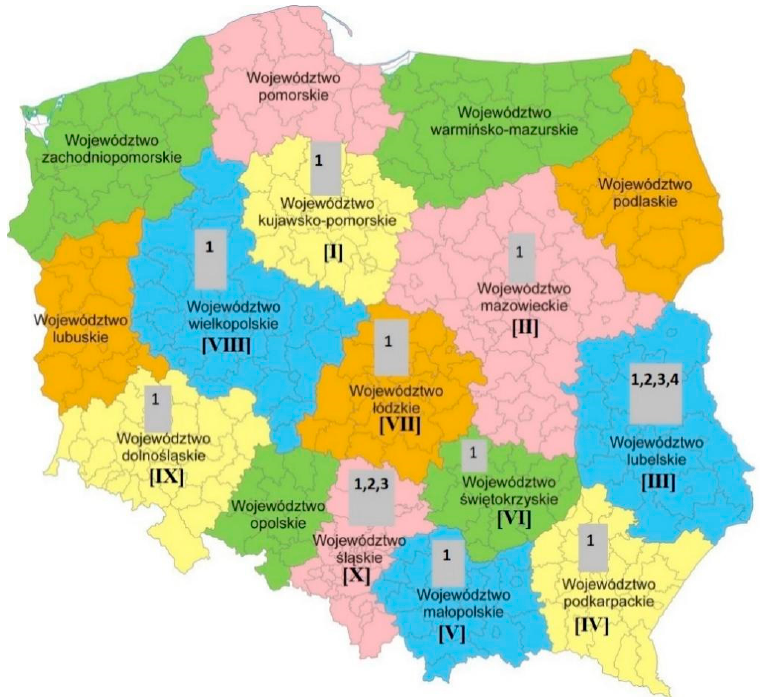
Figure 1. Area map outlining the origin of examined bottled waters. The types of sample origin are represented by numbers in bars (see Table 1). The codes of regions are given in square brackets.